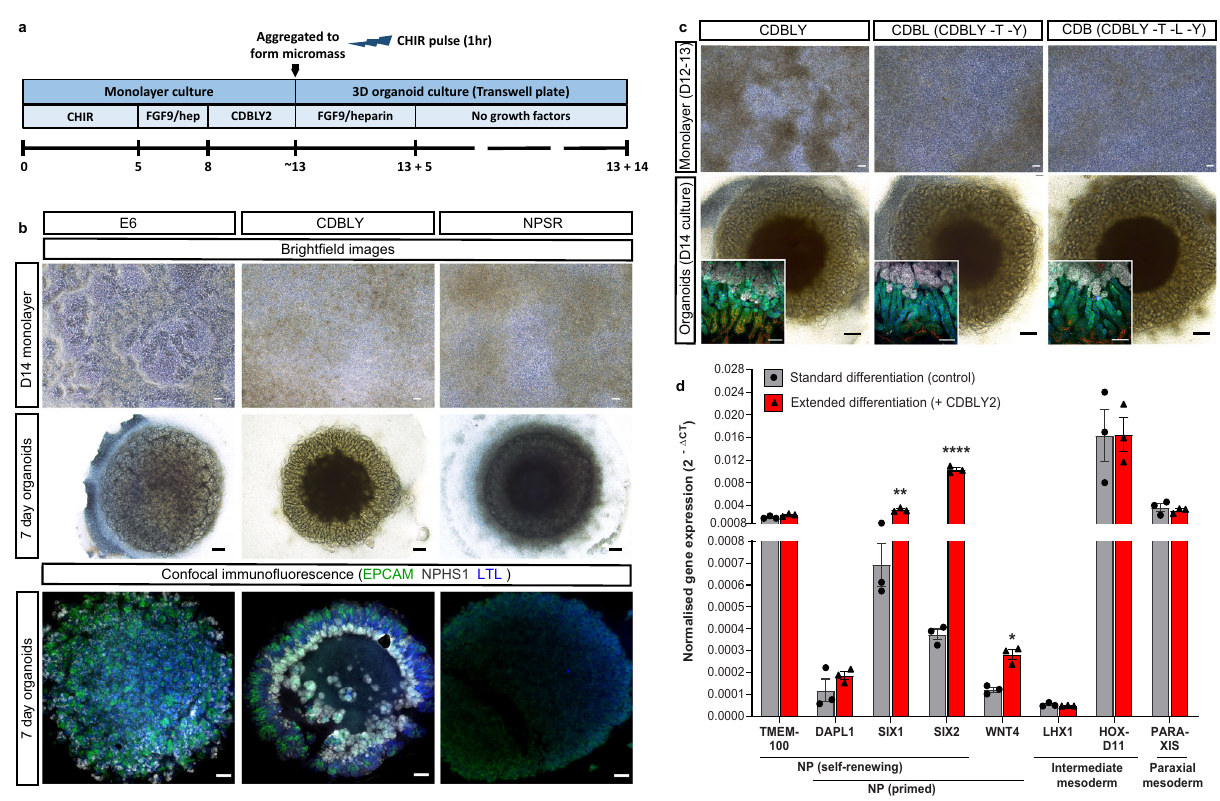
Fig. 1 | Extended monolayer culture in CDBLY supports nephron progenitors and preserves nephrogenic capacity. a Schematic depicting the extended dif- ferentiation protocol in CDBLY2. b Bright fi eld and confocal immuno fl uorescence images of extended monolayer differentiations in E6, CDBLY and NPSR, and resulting organoids. Immuno fl uorescence depicts nephrons (EPCAM; green), podocytes of glomeruli(NPHS1;grey),and proximaltubules (LTL;blue).Scale bars represent 100 µ m (monolayers) and 200 µ m (organoids). c Bright fi eld images of extended monolayer differentiations using CDBLY variations and resulting orga- noids, with inset confocal immuno fl uorescence images highlighting organoid nephron alignment and patterning. Immuno fl uorescence depicts nephrons